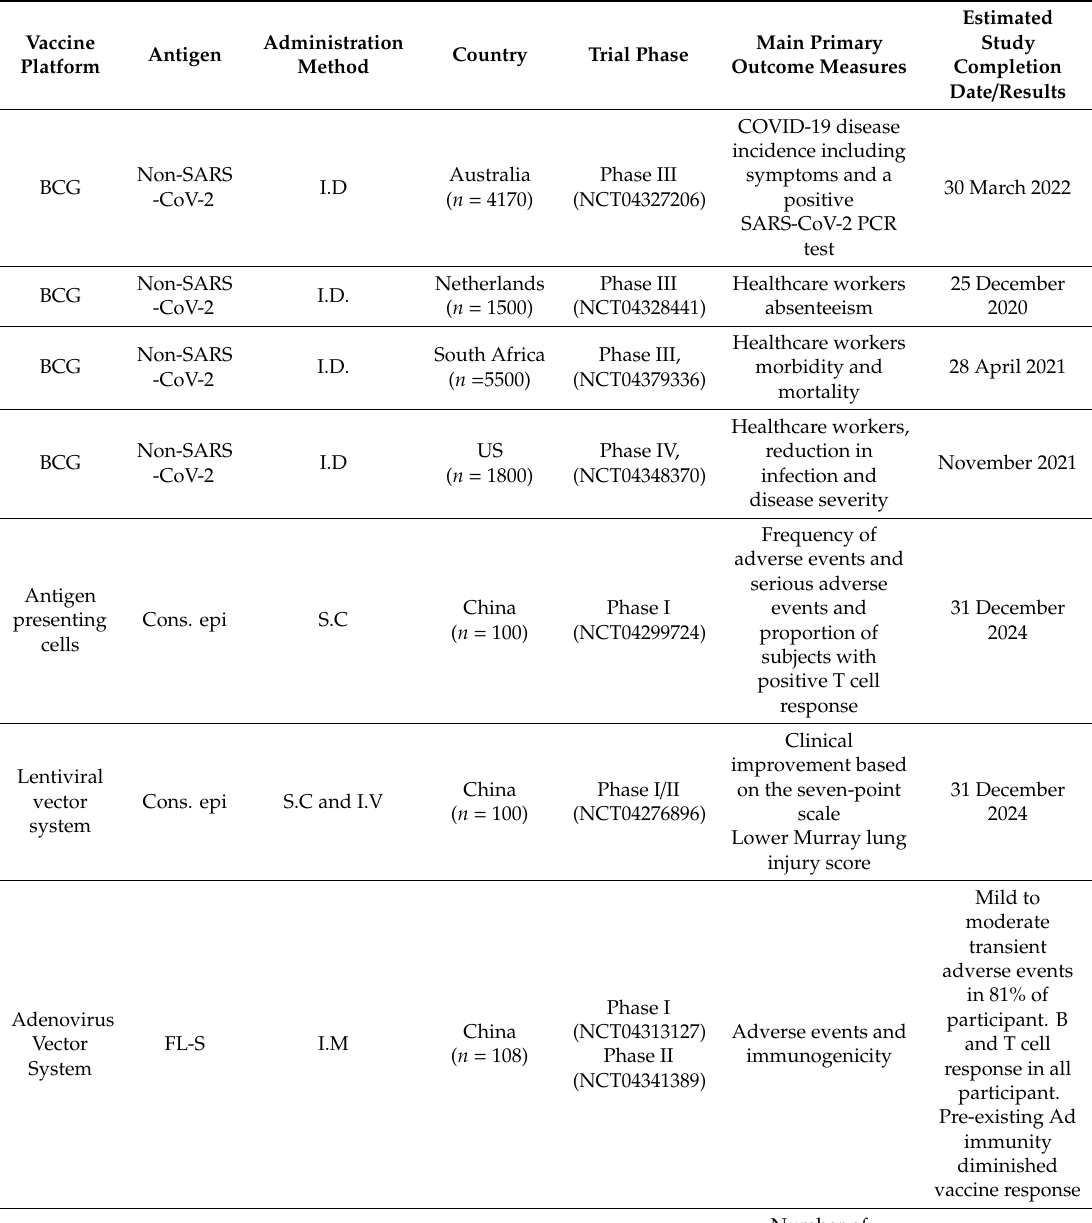
Table 2. Summary of current recruiting clinical trials for severe acute respiratory syndrome coronavirus 2 (SARS-CoV-2) found on clinicaltrials.gov and World Health Organization (WHO) database. Vaccine